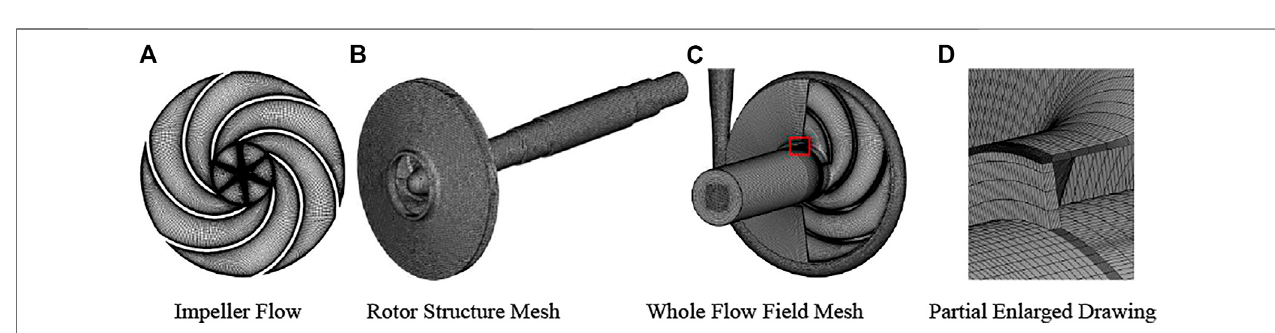
FIGURE 3 | Diagram of fl ow fi eld domain and rotor mesh. (A) Impeller fl ow. (B) Rotor structure mesh. (C) Whole fl ow fi eld mesh. (D) Partial enlarged